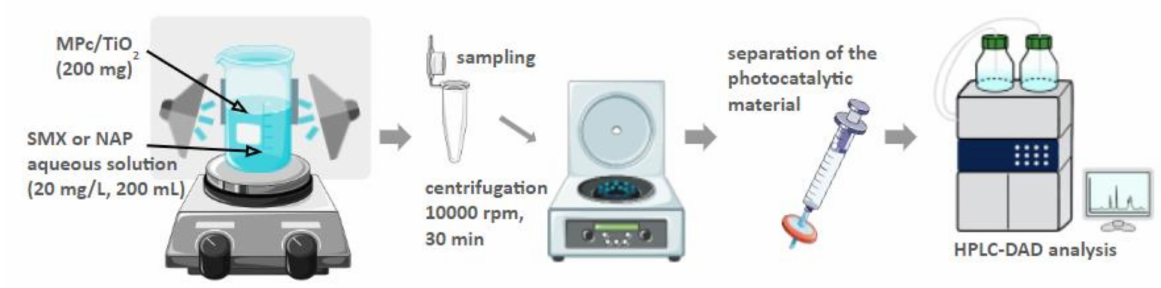
Figure 5. Schematic representation of the set-up and general procedure of the photocatalytic experi- ment in